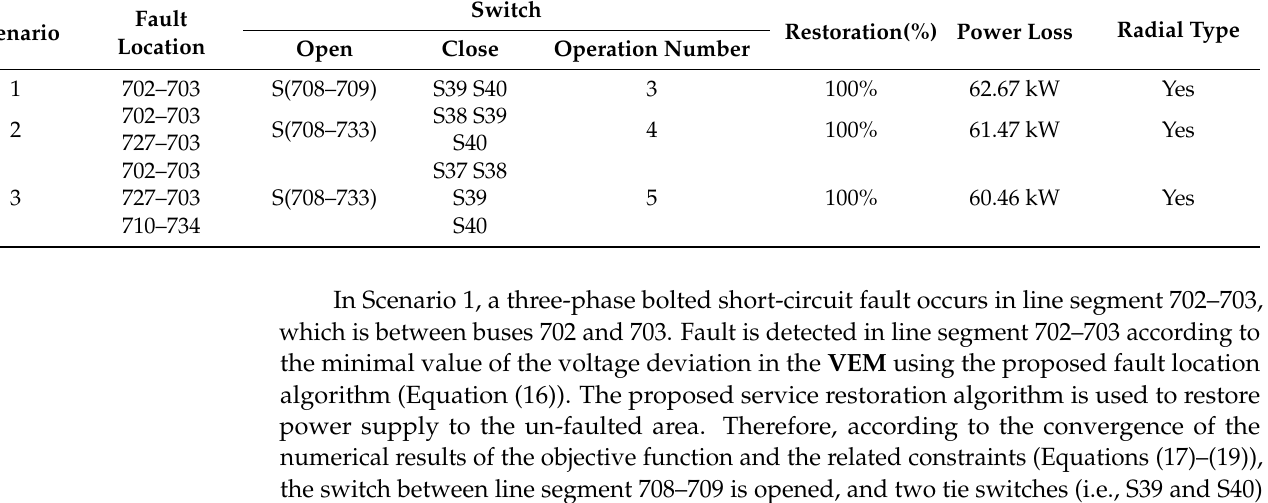
Table 3. Simulation results under grid-tied operation Table 2. Fault point assumption of each scenario.